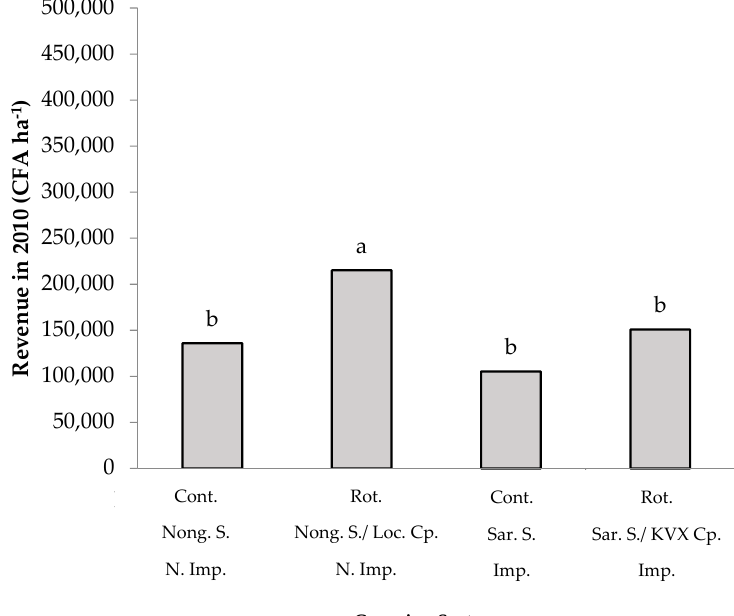
Figure 9. Mean grain and stover revenue for continuous sorghum or sorghum in rotation with cowpea. Sariaso 14 sorghum and KVX 396-4-4 cowpea are improved varieties, whereas Nongomsoba sorghum and the local cowpea have not been improved through breeding. Abbreviations: Cont.: Continuous; Rot.: Rotation; Nong. S.: Nongomsoba Sorghum; Sar. S.: Sariaso 14 Sorghum; KVX Cp.: KVX 396-4-4 Cowpea; Loc. Cp.: Local Cowpea; N. Imp.: Nonimproved; and Imp.: Improved. Columns with the same letter are not significantly di ff erent at p ≤